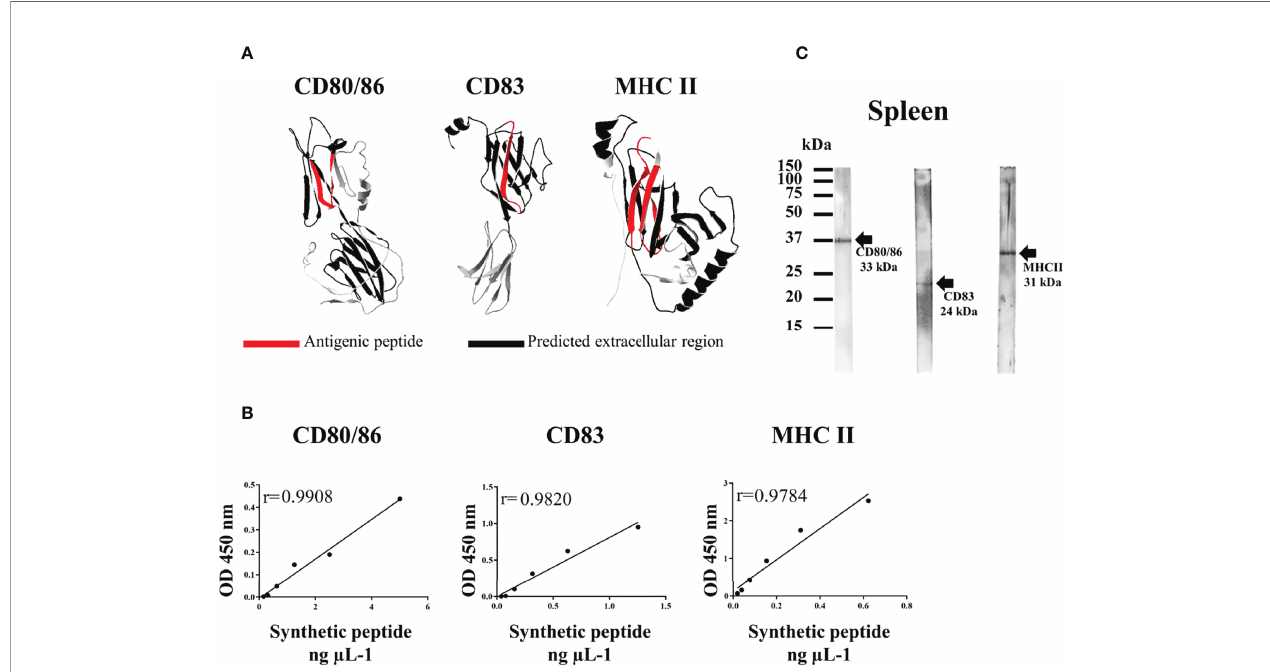
FIGURE 3 | Production and validation of antibodies against cell-surface markers of Atlantic salmon. (A) Three-dimensional modeling by homology for each protein, on the left: CD80/86, in the center: CD83 and on the right: MHC II. In red: antigenic peptides selected for synthesis and immunization. In black: the predicted extracellular region. (B) Calibration curve by indirect ELISA to establish the proportional relationship between the detection of the antibody produced (at 450 nm) and the concentration of the synthetic peptide (ng m l − 1 ). r: correlation coef fi cient. (C) Western blot to determinate the speci fi city of each antibody in a sample of spleen proteins (pool of four fi